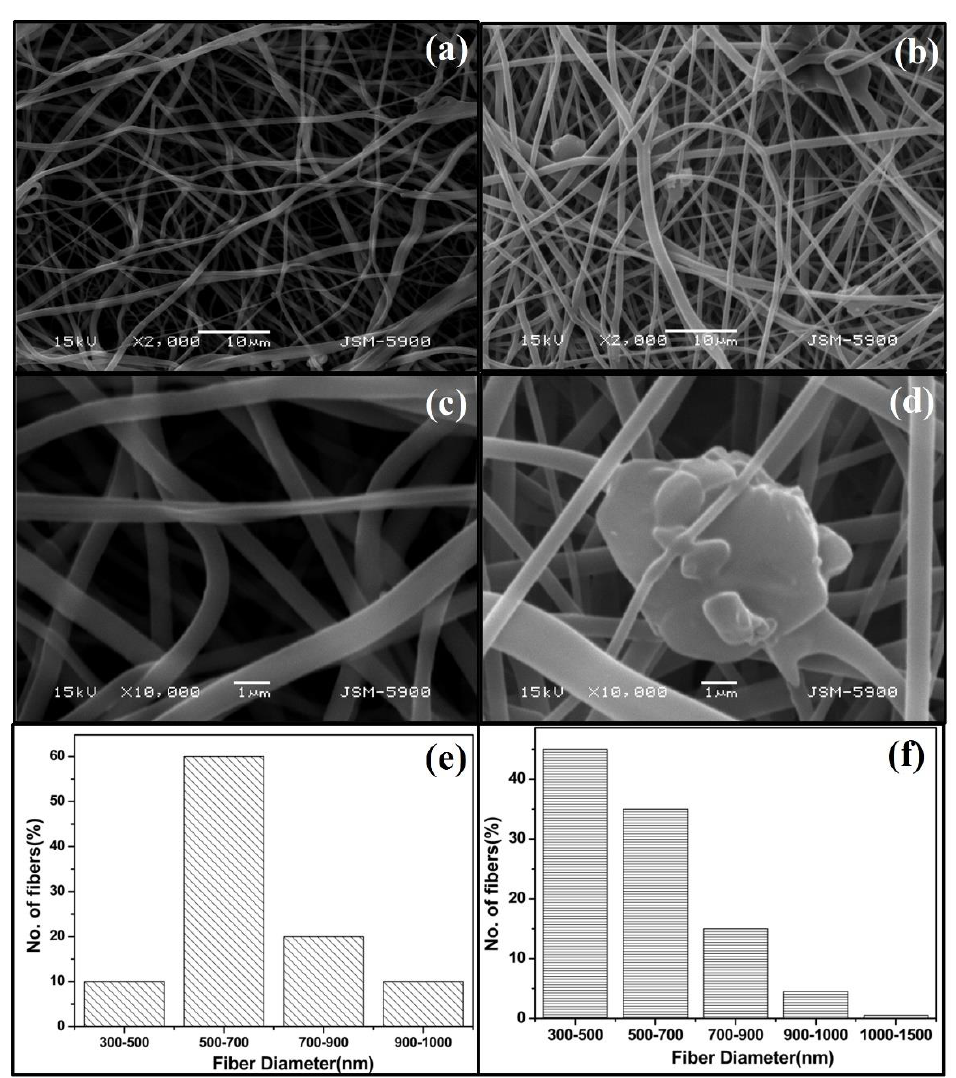
Figure 1. SEM metaphors of ( a , c ) pure PU and ( b , d ) POSS-grafted PU matrices at different intensifications and ( e , f ) fiber distribution of PU and POSS-grafted PU matrices, respectively.